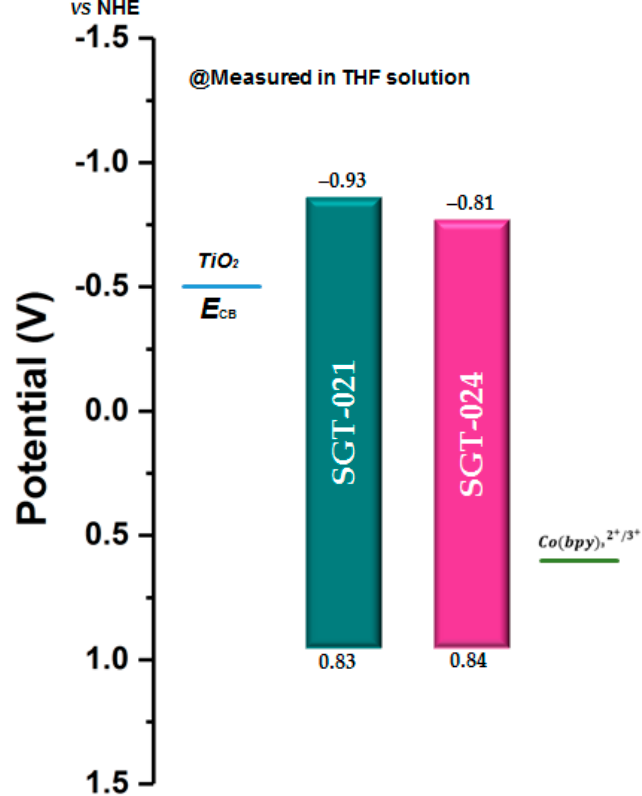
Figure 1. Absorption spectra and emission spectra of SGT-020 and SGT-024 in THF.